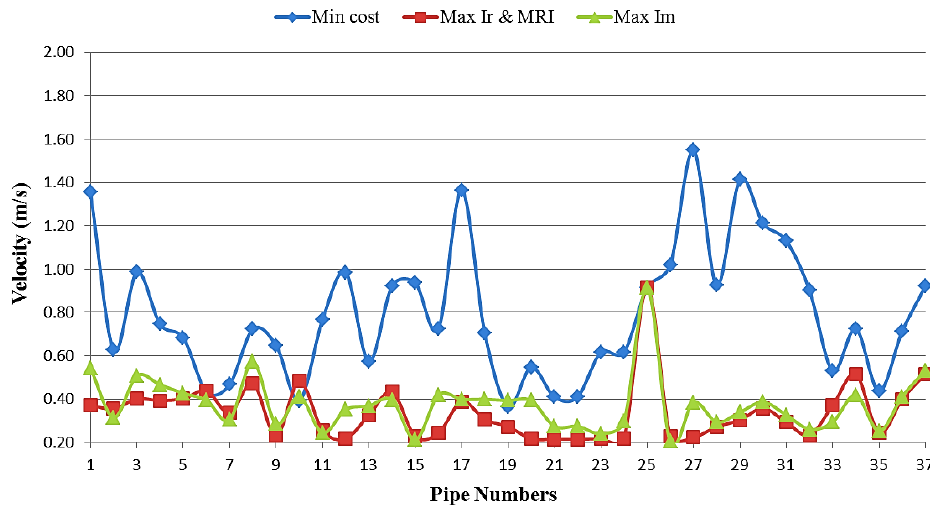
Figure 7. Velocity variations in pipes for the solutions of minimum cost and maximum I r , MRI, and I m